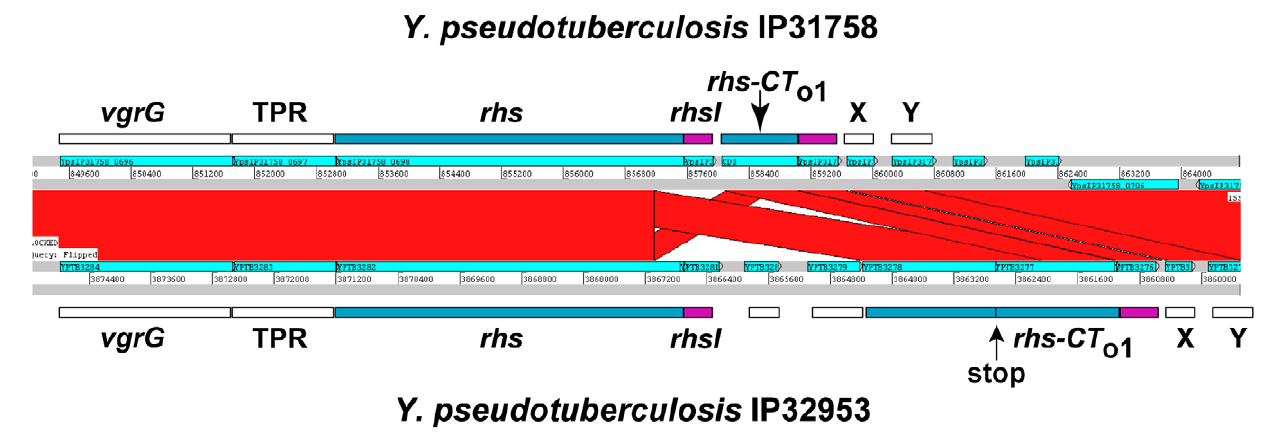
Figure 9. Rhs genes have variable CT encoding sequences, immunity genes, and orphan rhs-CT/rhsI modules. ACT comparison of related Rhs regions from Y. pseudotuberculosis strains IP31758 (top) and IP32953 (bottom). This region is highly conserved between the two strains, but the rhs genes encode unrelated CT sequences and the adjacent rhsI genes are unrelated. Both strains contain a related orphan rhs-CT/rhsI module. The orphan module in strain IP32953 has more upstream rhs coding sequence, but contains an in-frame stop codon in this retained sequence. The vgrG gene is a conserved component of Type VI secretion systems; TPR is a conserved gene encoding a potential tetratricopeptide repeat protein; and X and Y are conserved predicted genes of unknown function.